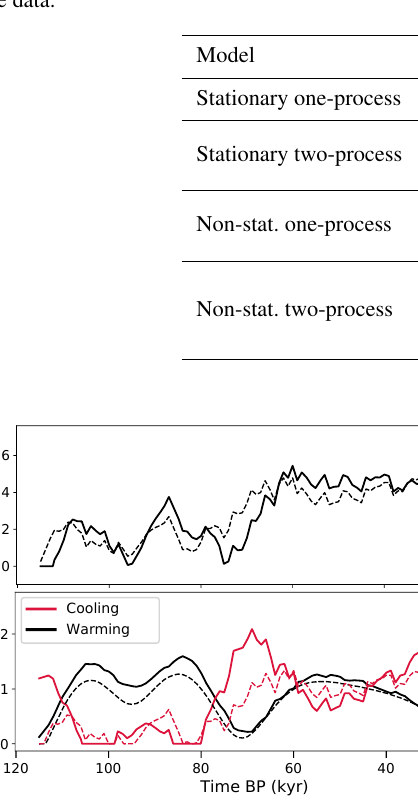
Table 1. Summary of model parameters, hypothesis test results and goodness of fit of the mean model time-varying indicators with respect to the data.